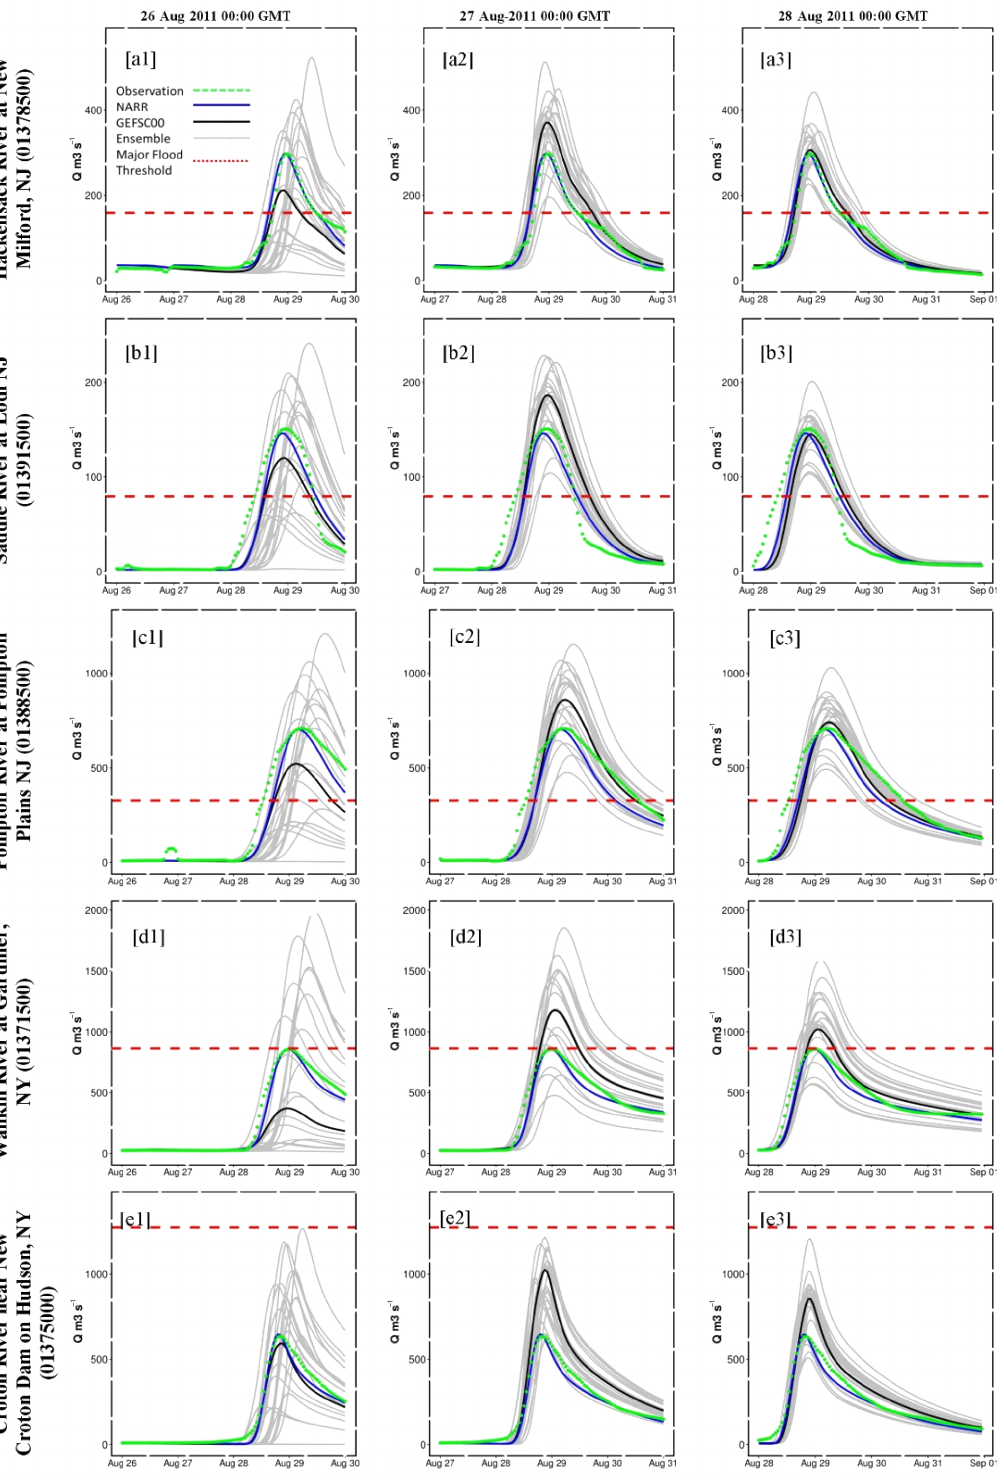
Figure 5. Ensemble streamflow forecasts compared to observed streamflow in selected stations at lead times of 72, 48 and 24h from the observed peak flow; reported time is in